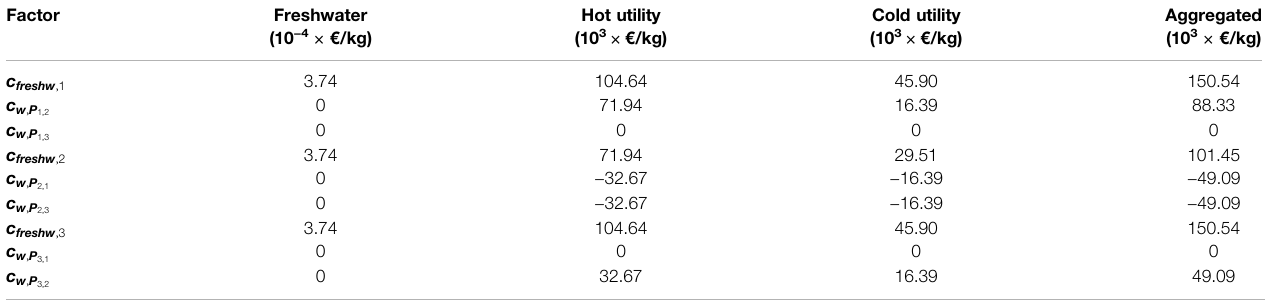
TABLE 7 | Values for the factors of the